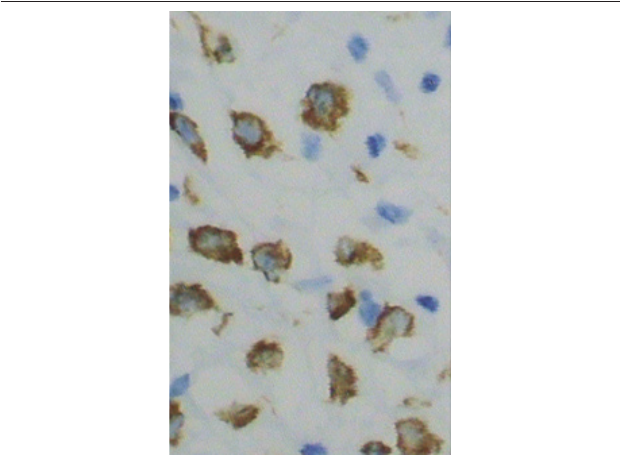
FigurE 2 − Desmin immunostaining